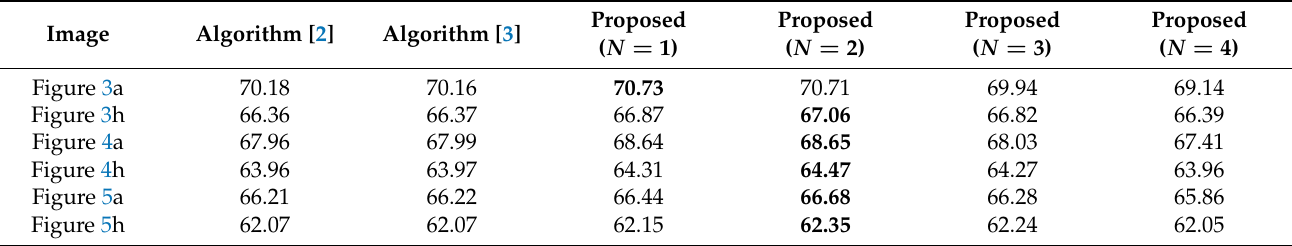
Table 1. PSNR values of the reflection suppression results in Figures 3–5. The best value in each row is shown in